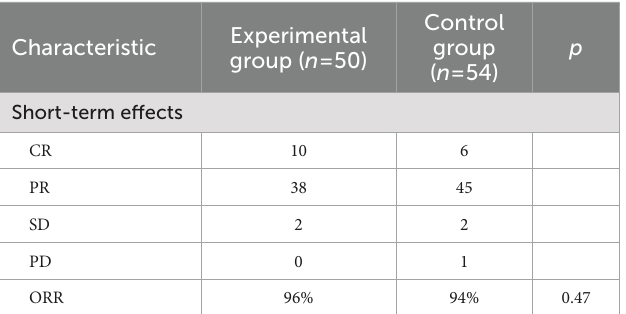
TABLE 4 Response rate to first-line concurrent chemoradiotherapy treatment.